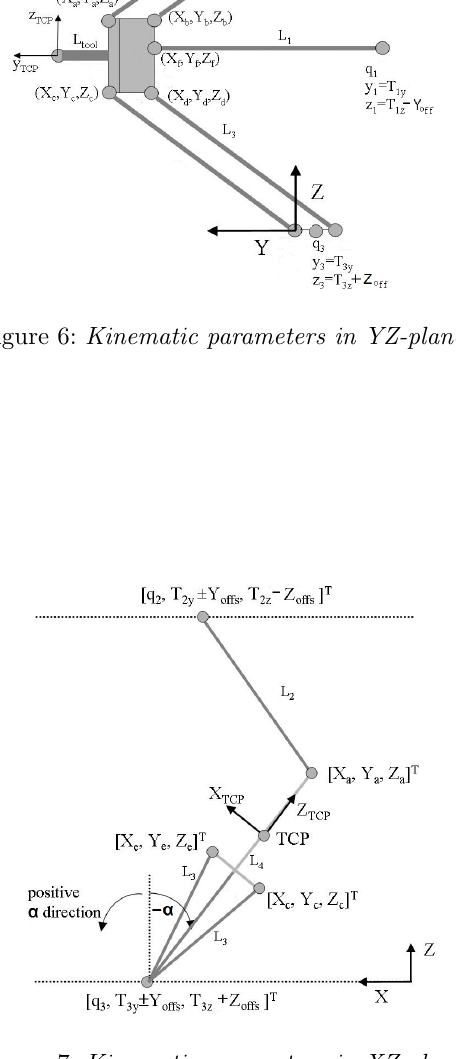
The normalised vectors pointed from the actuator positions to the points A, B, C, D, E, F on the